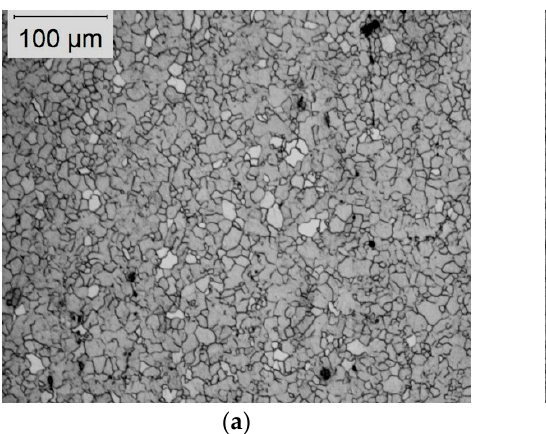
Figure 13. Microstructures of AZ31 after two sc-ECAE passes at temperatures of 250 °C ( a ) and 275 °C ( b ). The large grains in ( a ) are oriented along the extrusion direction.